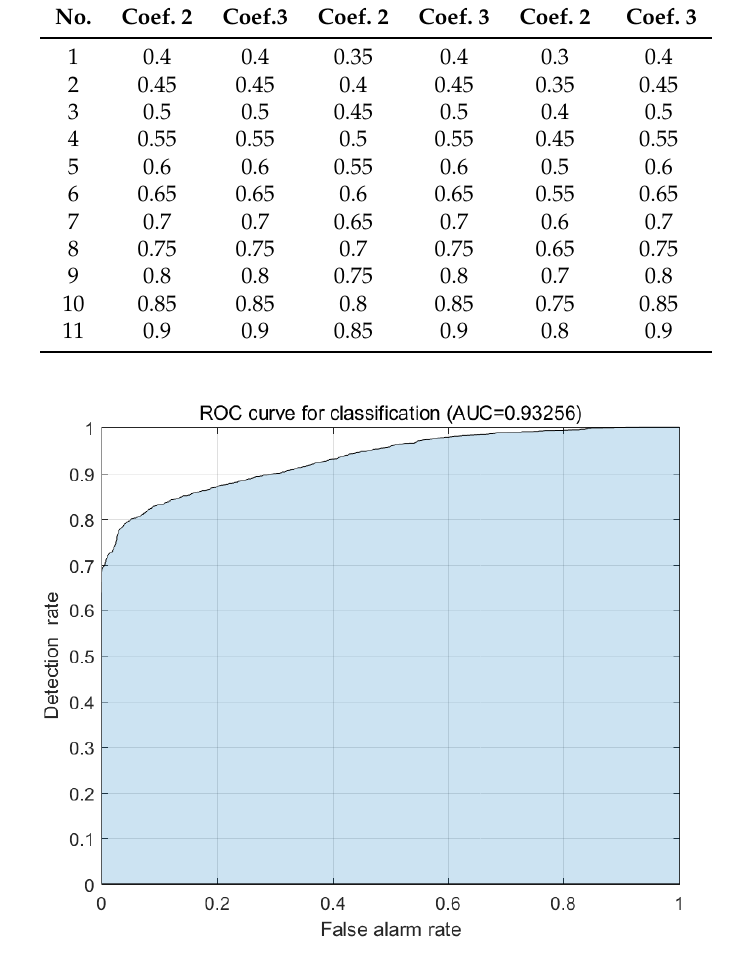
Figure 15. One example of 1000 ROC curves with average AUC = 0.9325 and its standard deviation = 0.0038.